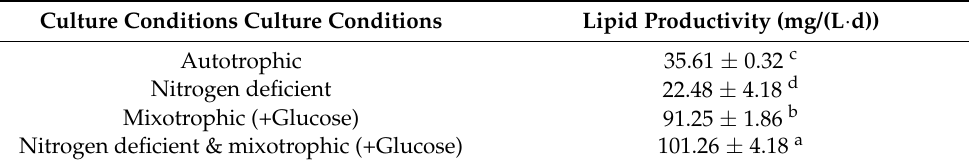
Table 2. Lipid productivity of P. kessleri TY under different culture conditions on the 7th